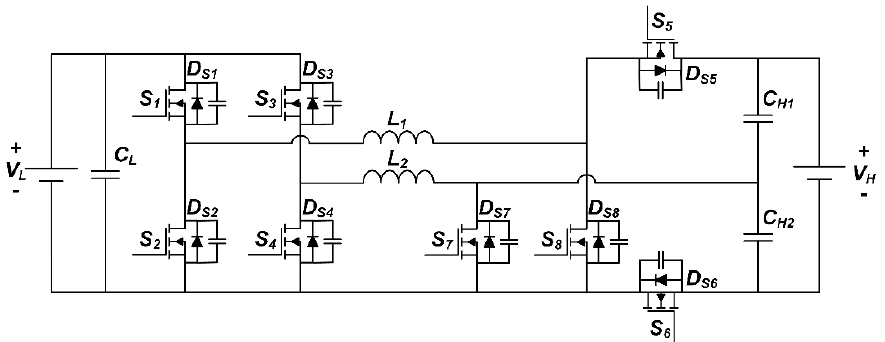
Figure 5. Two-phase interleaved cascaded bidirectional buck–boost/half-bridge DC–DC con- verter.